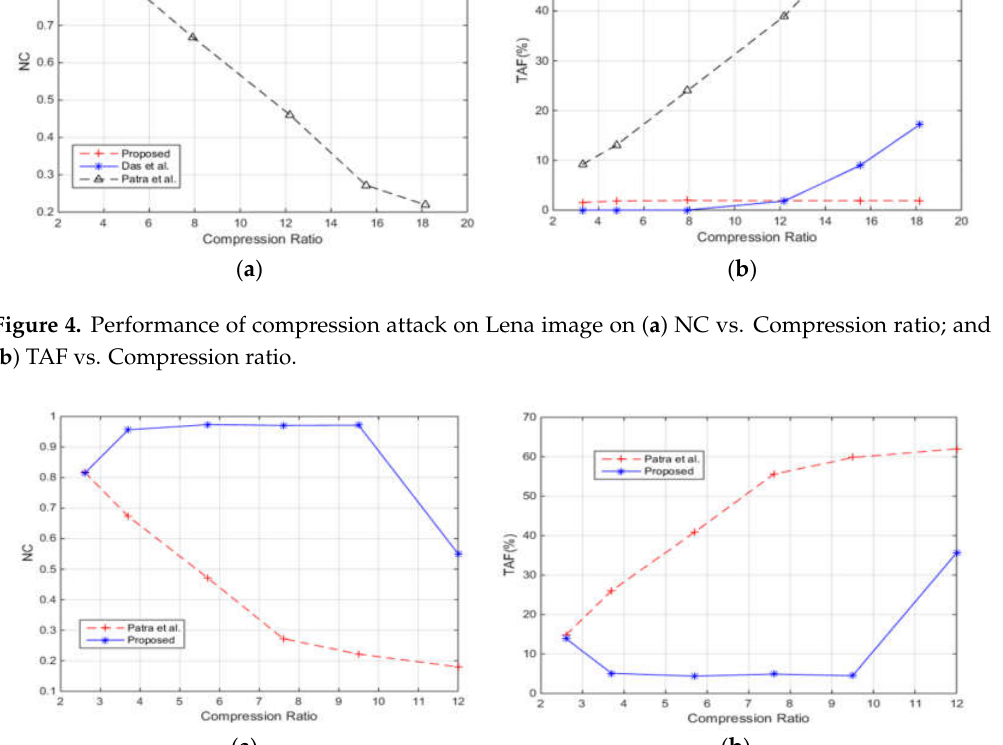
Figure 6. Performance of compression attack on Boat image on ( a ) NC vs. Compression ratio; and ( b ) TAF vs. Compression ratio.